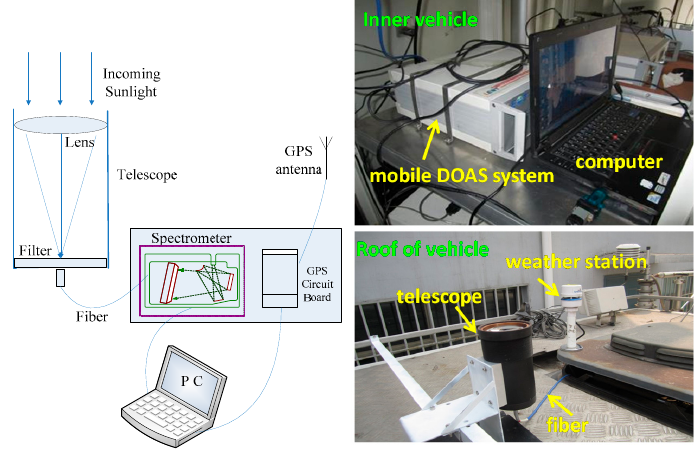
Figure 2. Mobile DOAS system.